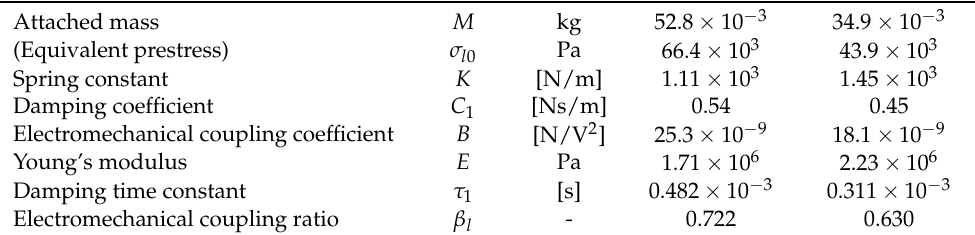
Table 3. Estimated parameters of the mechanical model and the electromechanical